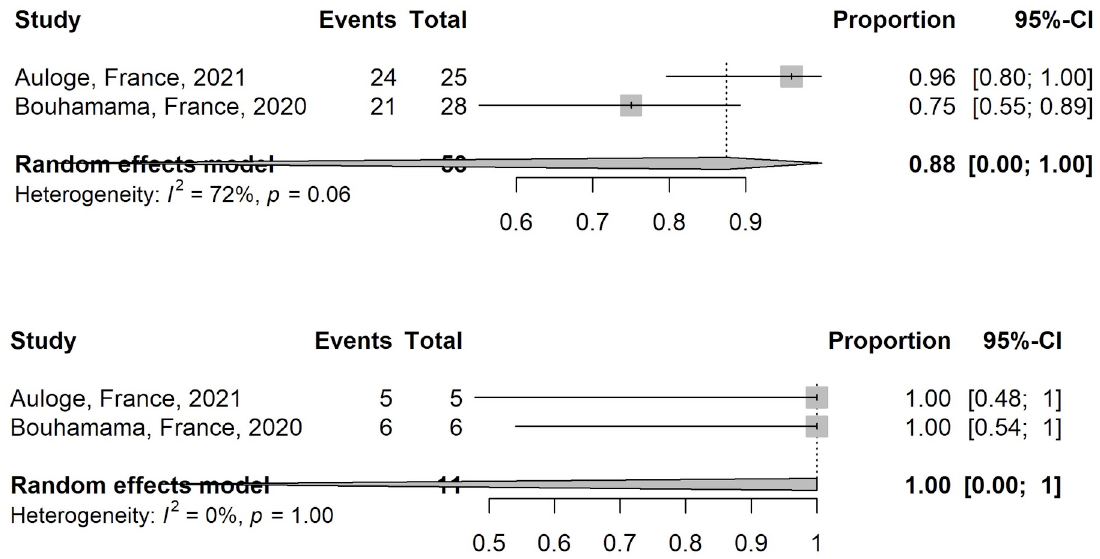
Fig 6. Comparison of the proportion of patients showing decrease in visual analogue scale (VAS) > = 3 for those with VAS > = 3 before treatment (Fig 6A) and proportion of patients showing total disappearance of pain for those with VAS < 3 before treatment (Fig 6B).